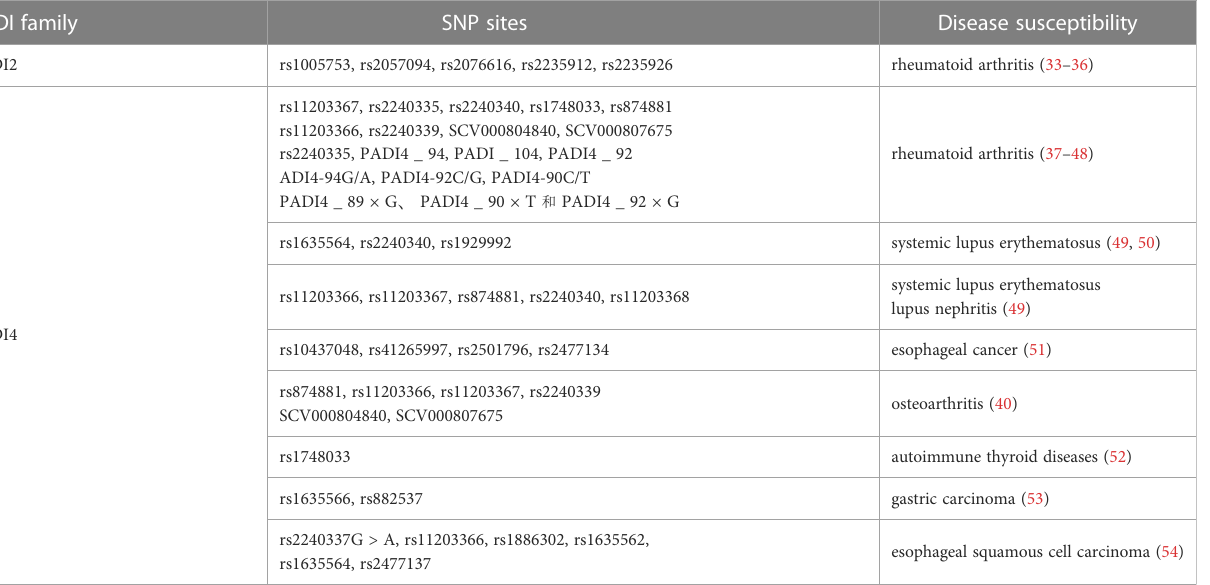
TABLE 2 SNP analysis of the PADI